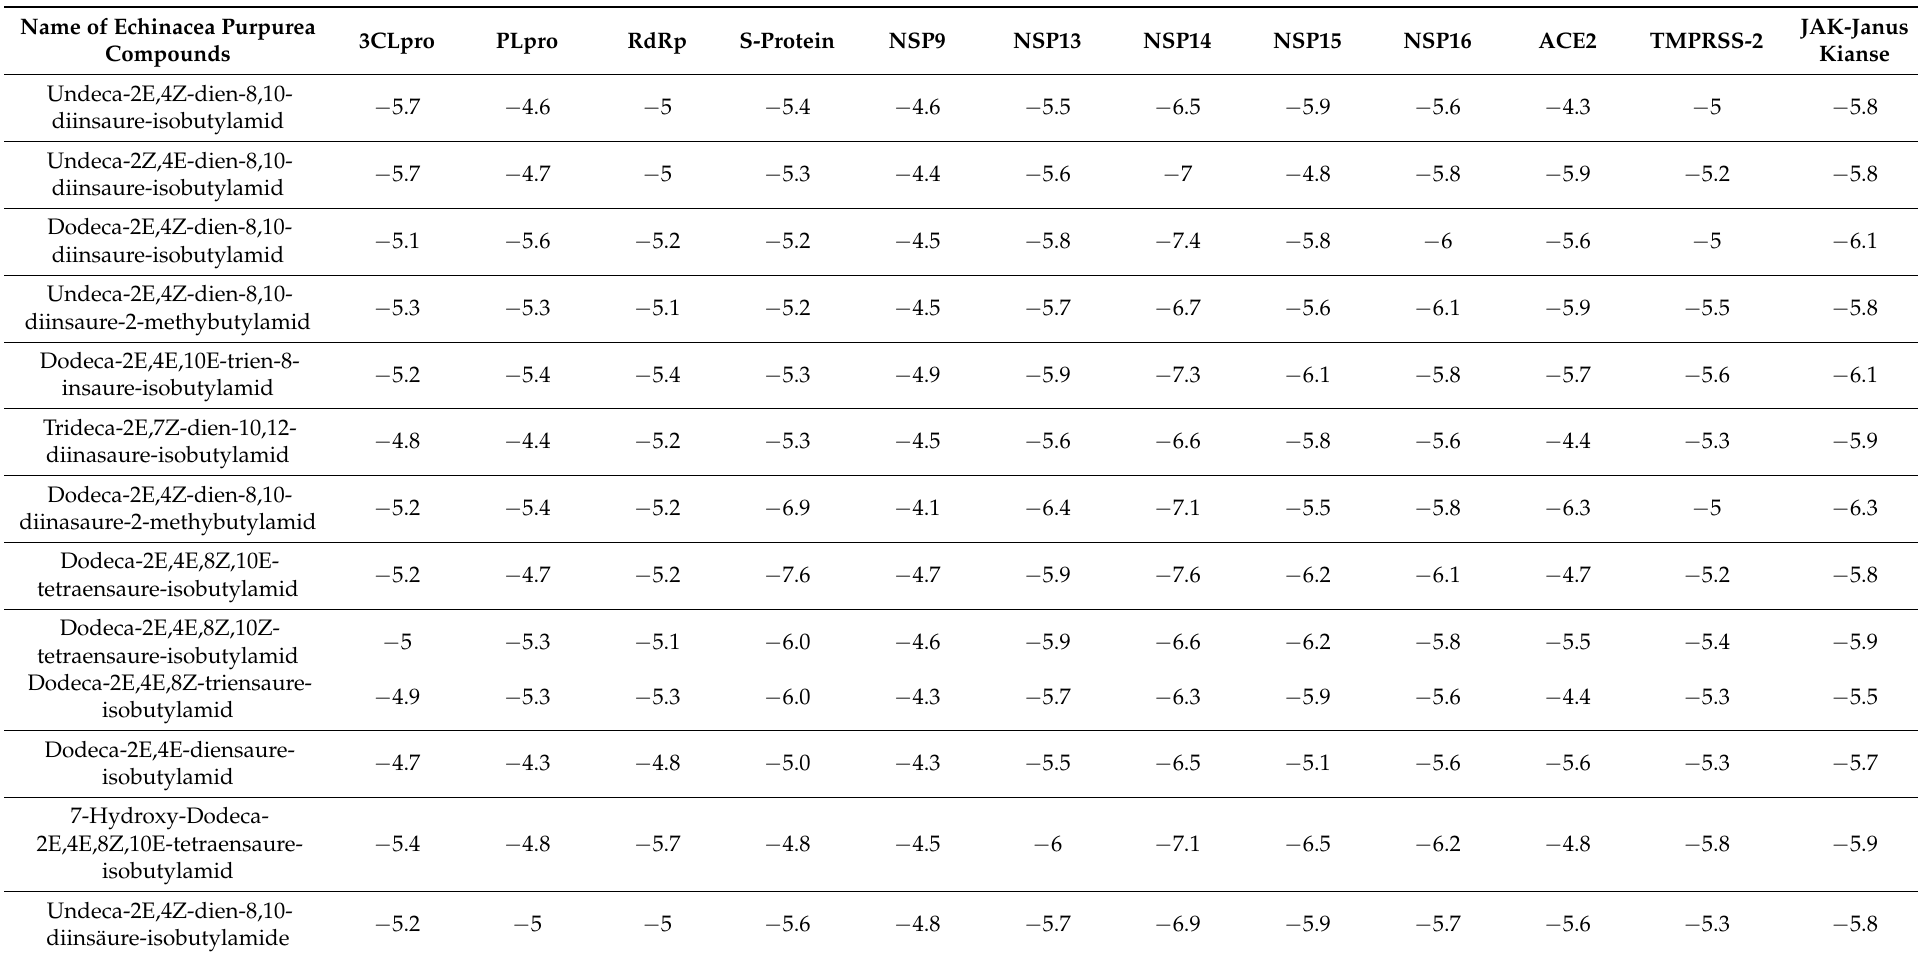
Table 1. The binding affinity of compounds of Echinacea purpurea against various target proteins of SARS-CoV-2 virus and of human cells in kcal/mol using Schrödinger XP Glide software